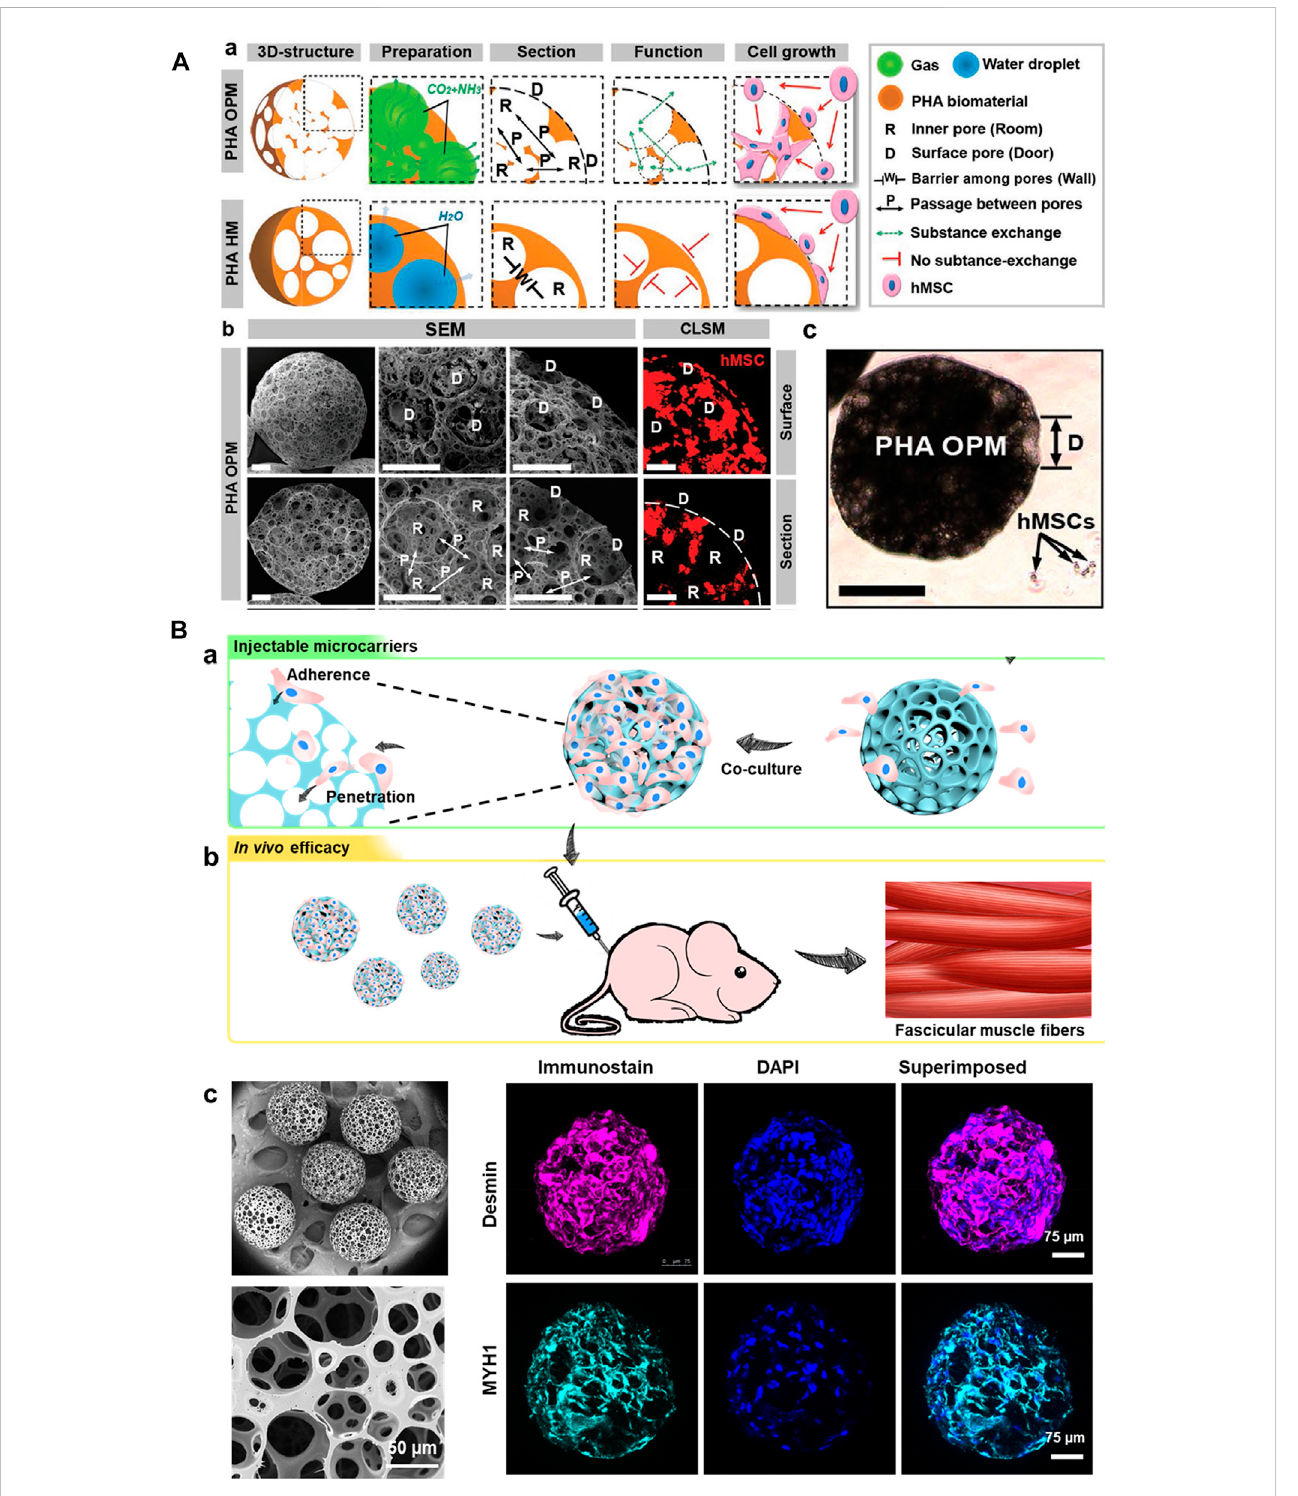
FIGURE 2 (A) Structures of PHA highly open PMs (PHA OPMs) and traditional PHA hollow microspheres (PHA HMs), respectively. a) Illustrations of PHA OPM and HM,including3Dstructures,preparation,section,functions,andcellgrowth.b)SEMimagesofsurfacesandsectionsofPHAOPMandconfocallaserscanning microscopy (CLSM) images of hMSCs adhered to PHA HOPM. The bars are 50 μ m. The actin of hMSC is stained in red. D: surface pore (door); R: inner pore (room); P: passage; and W: barrier among pores (wall). c) Sizes of hMSCs digested with trypsin versus a PHA HOPM. The bar is 150 μ m. D: surface pore (door). Reproduced with permission from Ref. (Wei et al., 2018). Copyright 2018, John Wiley & Sons. (B) a) Schematic illustration showing the fabrication of modular cell-laden HOPMs by populating the C2C12 cells on the microcarriers in vitro , and b) evaluating their performance in vivo after administering these cell-laden HOPMs in nude mice. c) SEM images showing the size distribution of PLGA HOPMs, and surface morphology of a microcarrier as well as immunohistological analysis of myoblasts in the PLGA HOPMs by staining them against desmin and MYH1 (counterstained by DAPI for nuclei) for 7 days. Reproduced with permission from Ref. (Kankala et al., 2019), Copyright 2019, John Wiley &